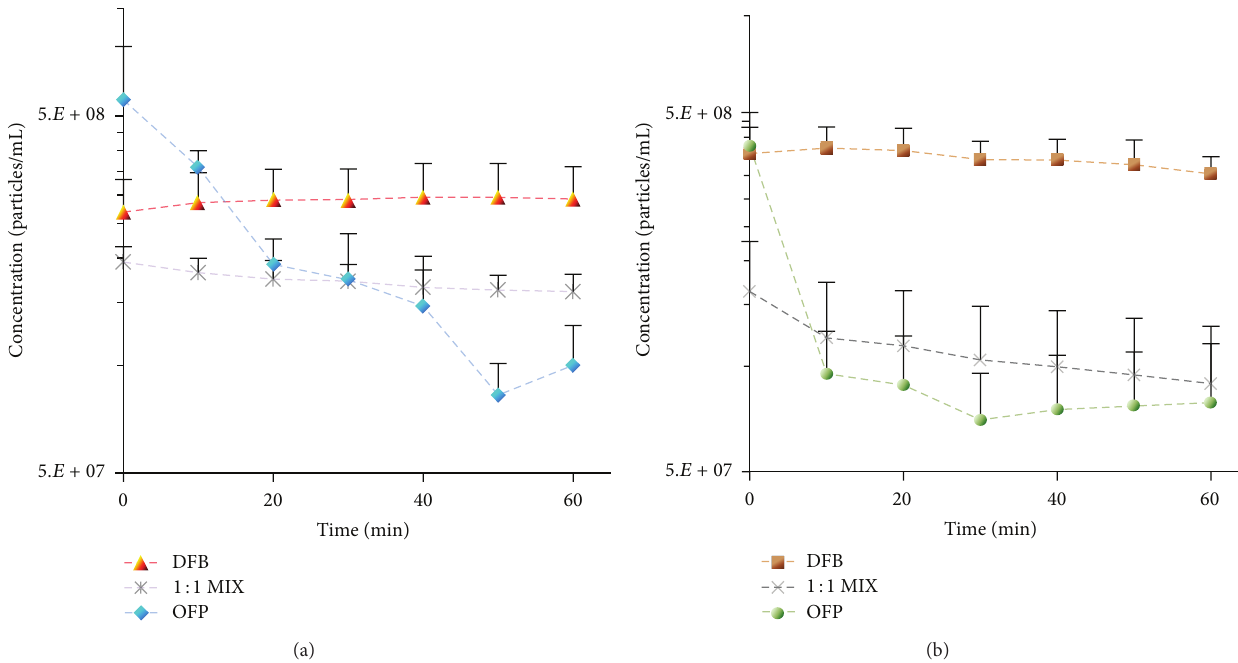
Figure 5: Change in concentration over time for droplet samples of each perfluorocarbon at (a) 22 ∘ C and (b) 37 ∘ C. Reprinted from [77], Copyright 2012, with permission from